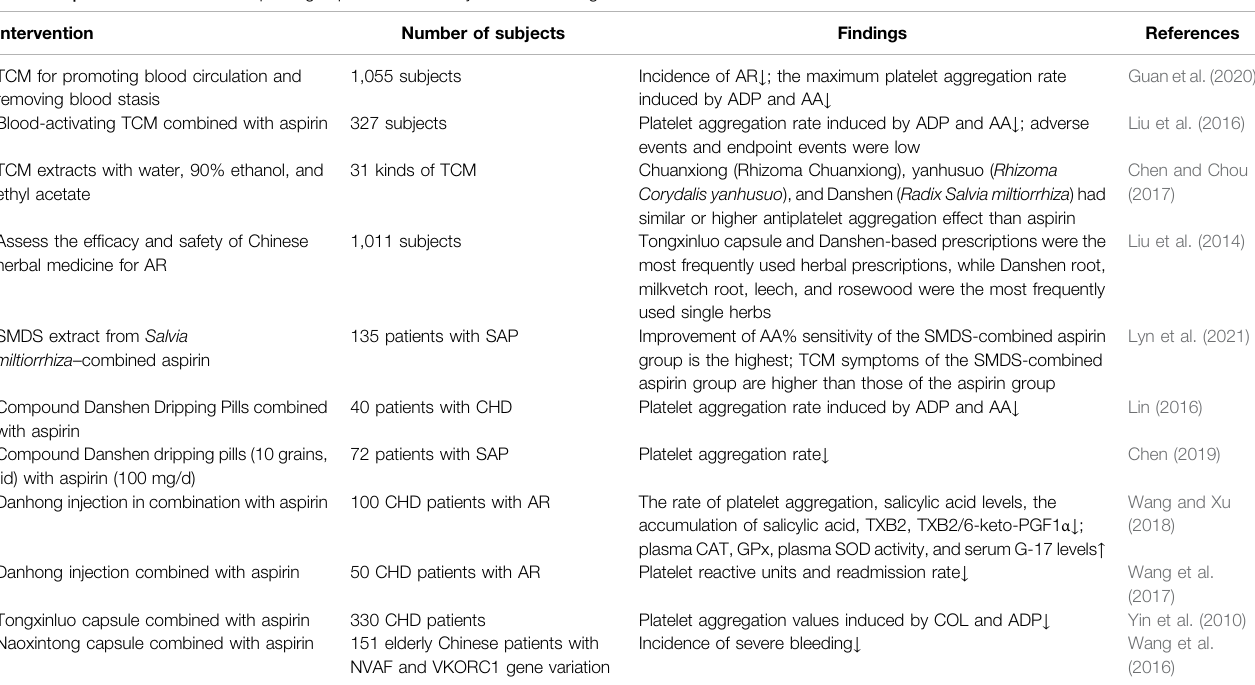
TABLE 1 | Research studies on improving aspirin resistance by blood-activating herbs.